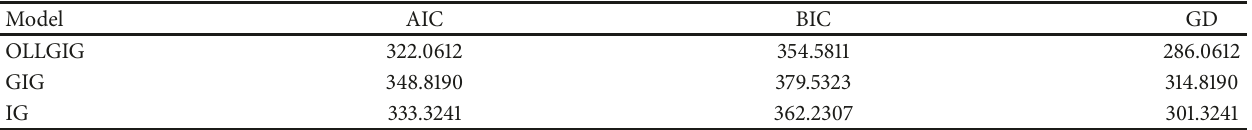
Table 9: Goodness-of-fit measures for the price of urban property